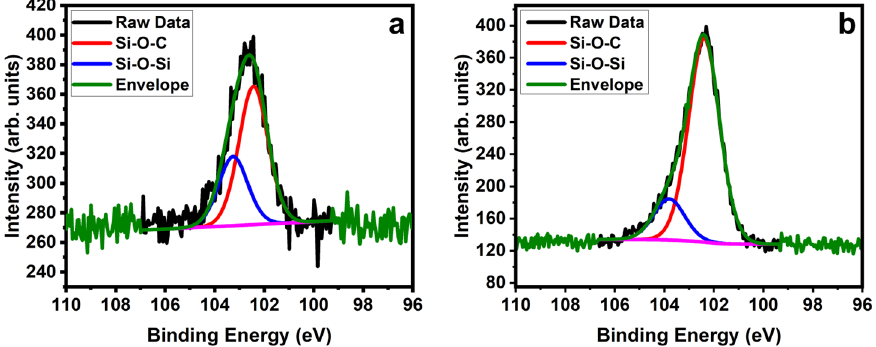
Figure 4. XPS of the Si 2p peak of carboxylated SWNTs after silanization using (a) toluene and (b) DMF as solvent.